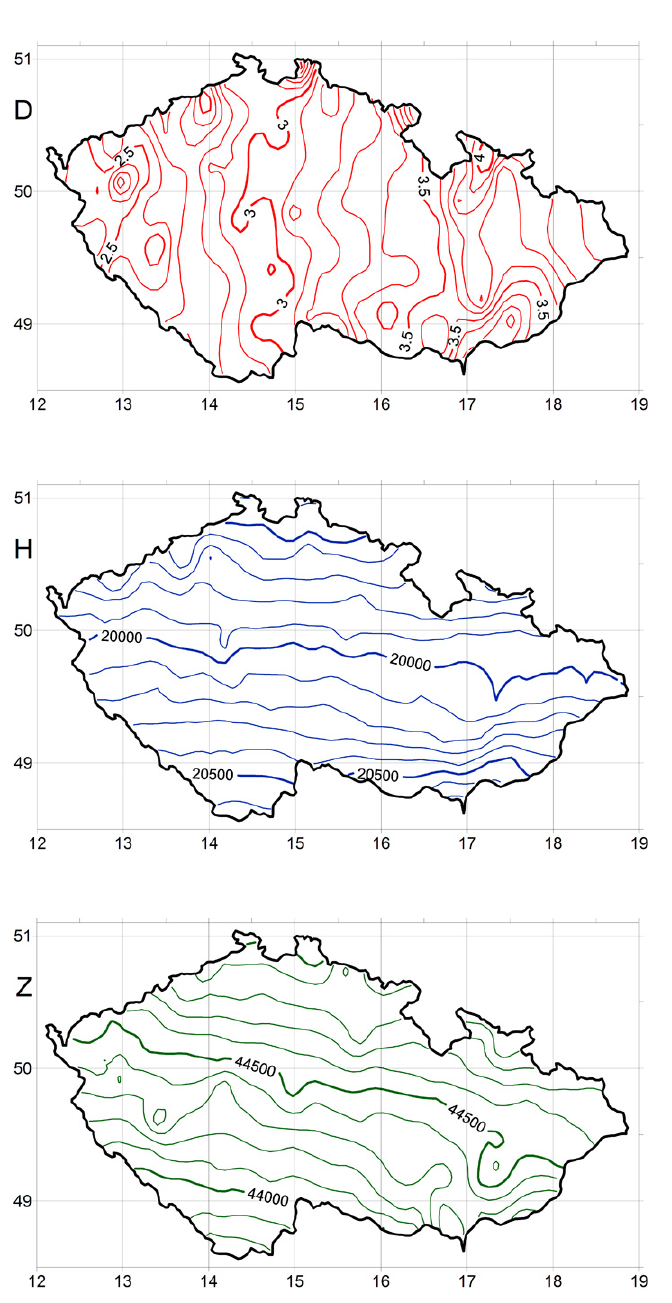
Figure 5. Maps of the geomagnetic field for the epoch 2010.5 derived from the magnetic survey carried out between 1994 and 1996 [Hejda et al. 1999] and linear model of secular variation between 1995.5 and 2010.5. Declination is given in degrees of arc, contour interval is 0.1 degree. Horizontal and vertical components are given in nT, contour interval is 100